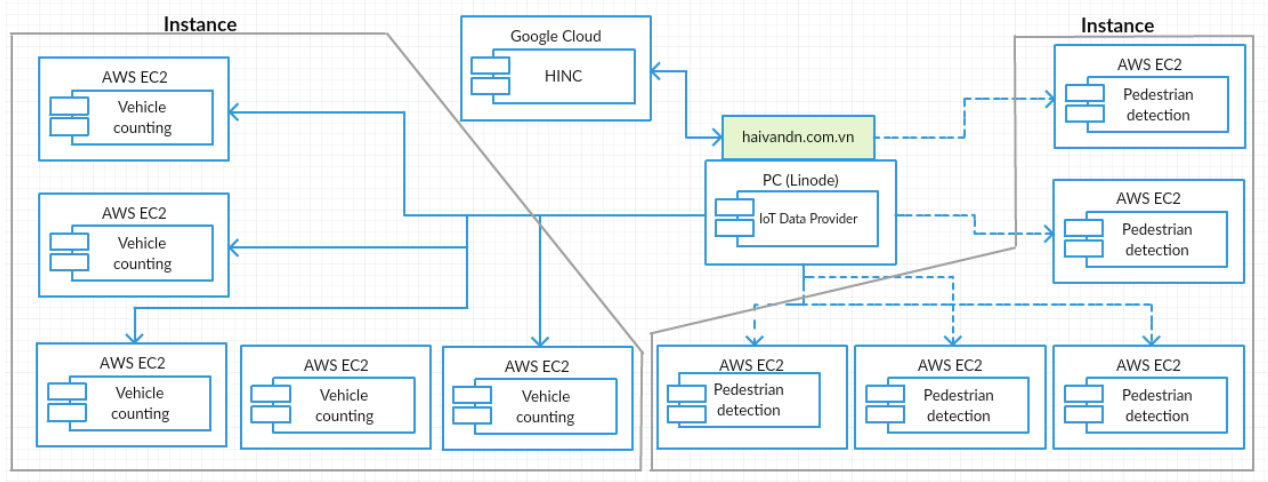
Figure 13. General resource settings for experiments